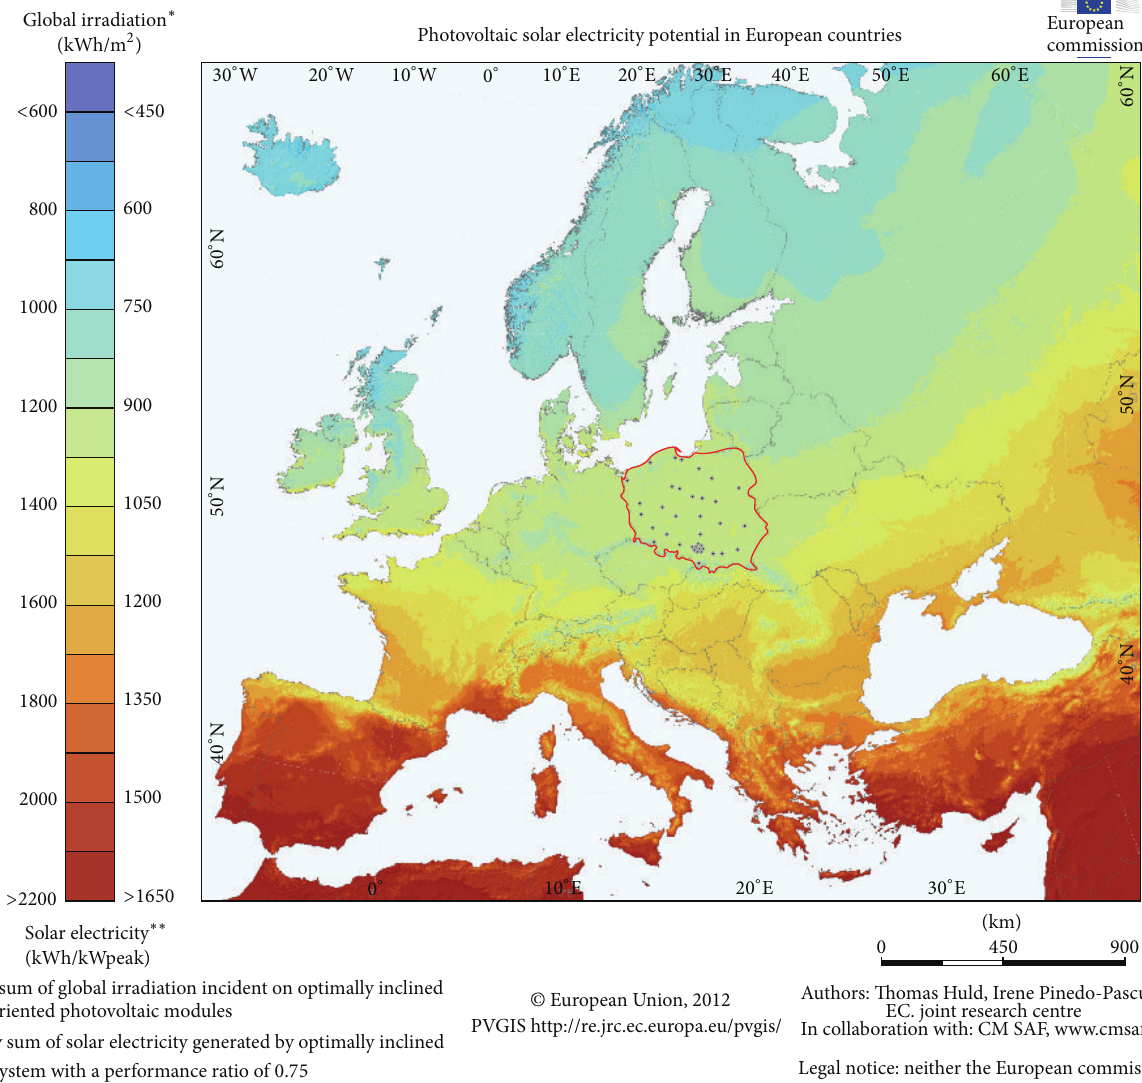
Figure 1: Global irradiation incident on optimally inclined PV modules in Europe. Key: Polish border outline: red line; dots: selected cities. Map source: